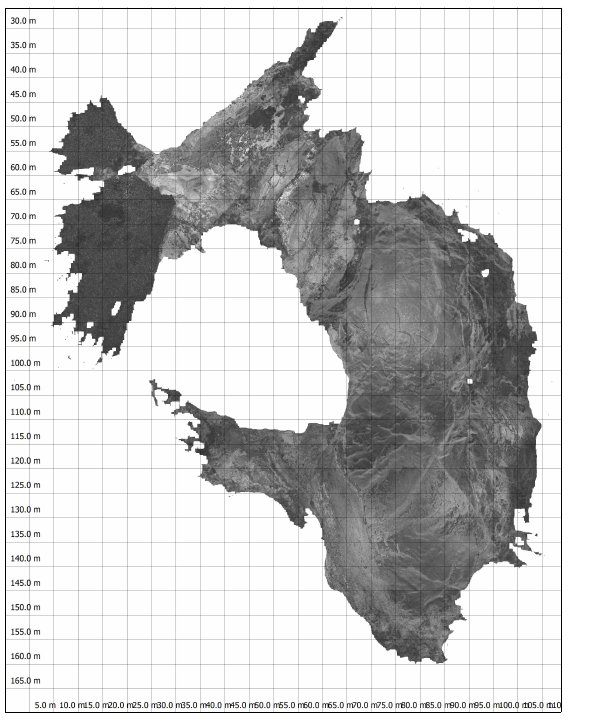
Figure 9. The orthophoto resulting from Z+F LaserControl .